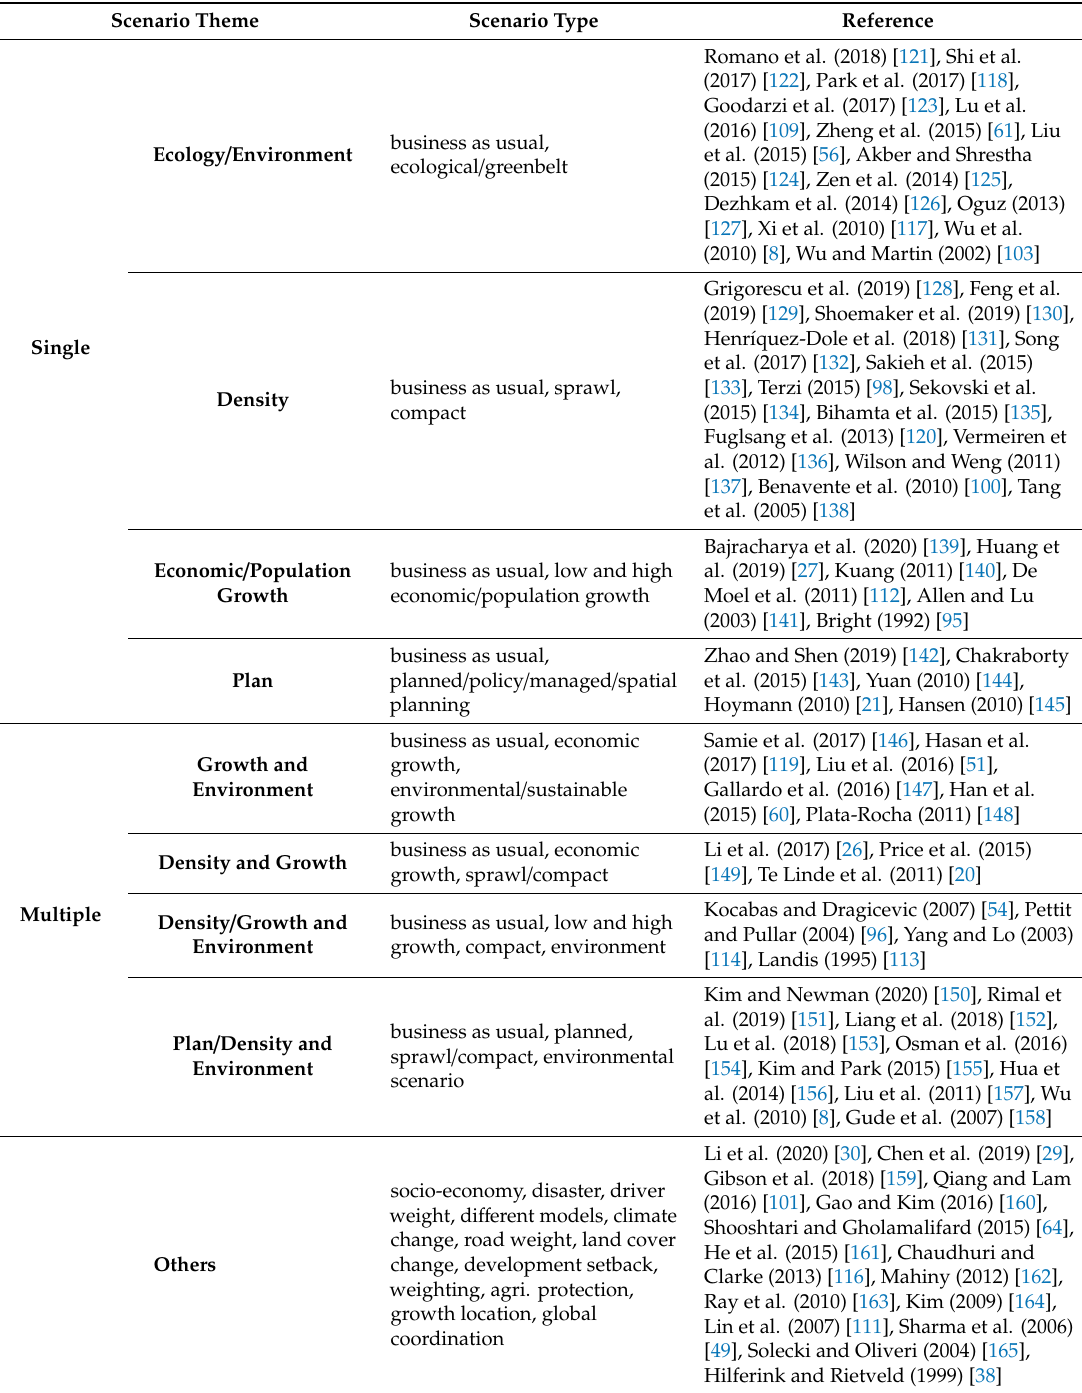
Table 3. Scenario types in Land Change Modeling